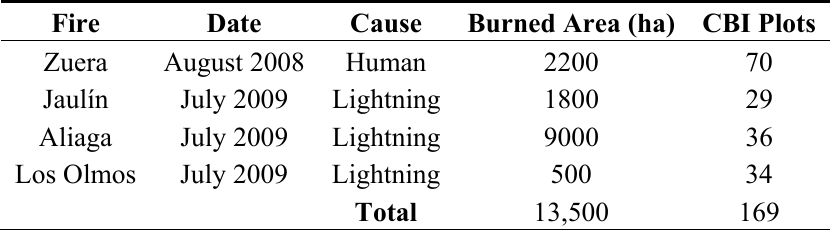
Table 1. Fire events and the corresponding field plots